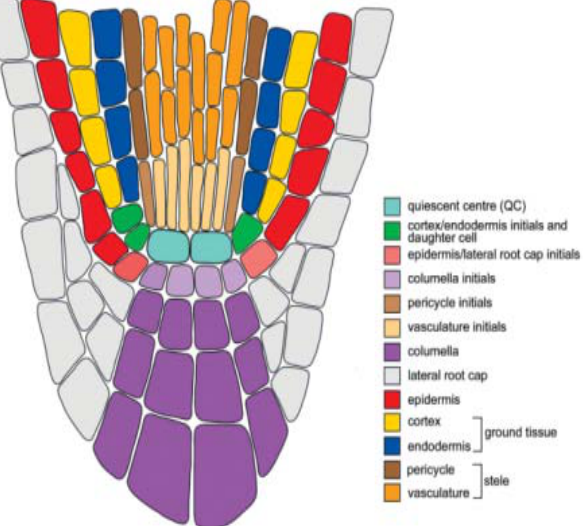
Figure 1: Cell organization of the root meristem in Arabidopsis thaliana as presented in